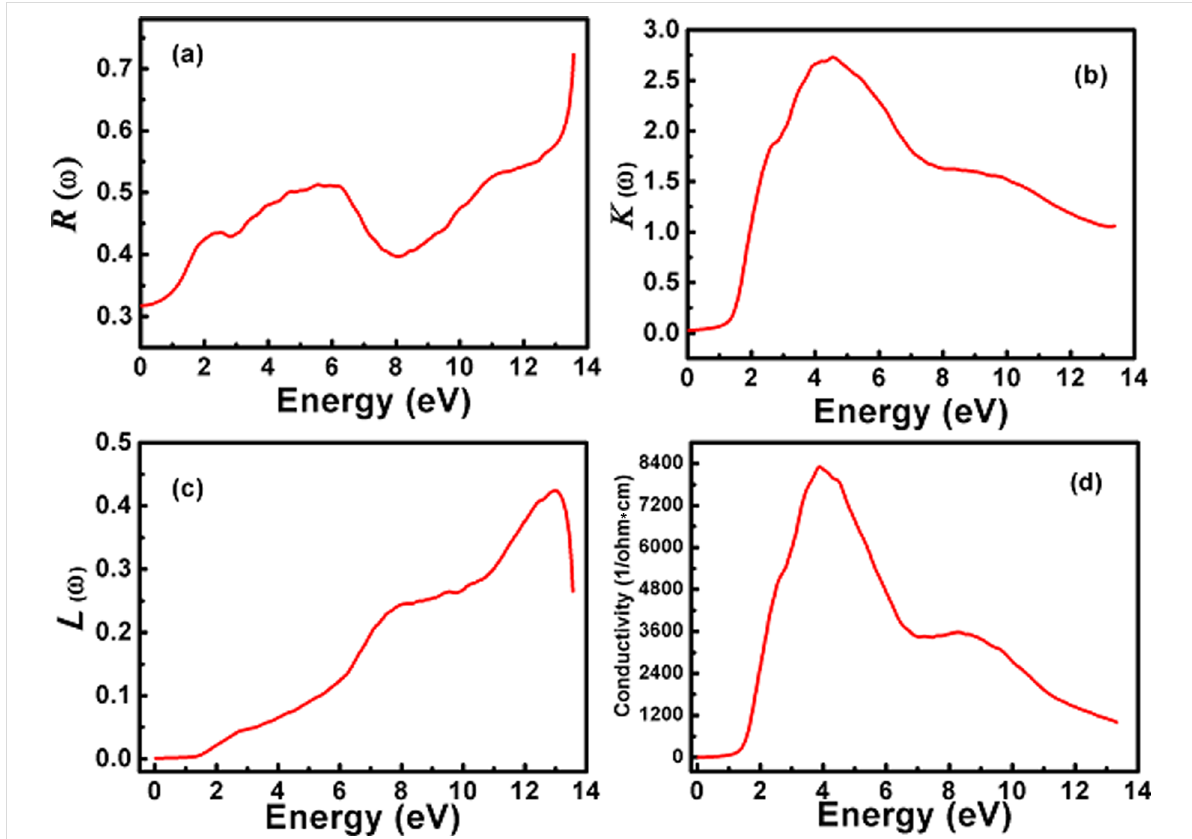
Figure 12: Calculated (a) reflectivity R ( ω ), (b) extinction coefficient K ( ω ), (c) energy loss function and (d) real optical conductivity as a function of energy for the cubic π -SnSe alloy. The extinction coefficient is illustrated in (b) as a function of photon energy. The static value of K (0) for the π -SnSe is negligibly small until it reaches its bandgap value (1.41 eV). After this energy value, the value of K ( ω ) starts to rapidly increase until it reaches its maximum value of 2.72 at 4.61